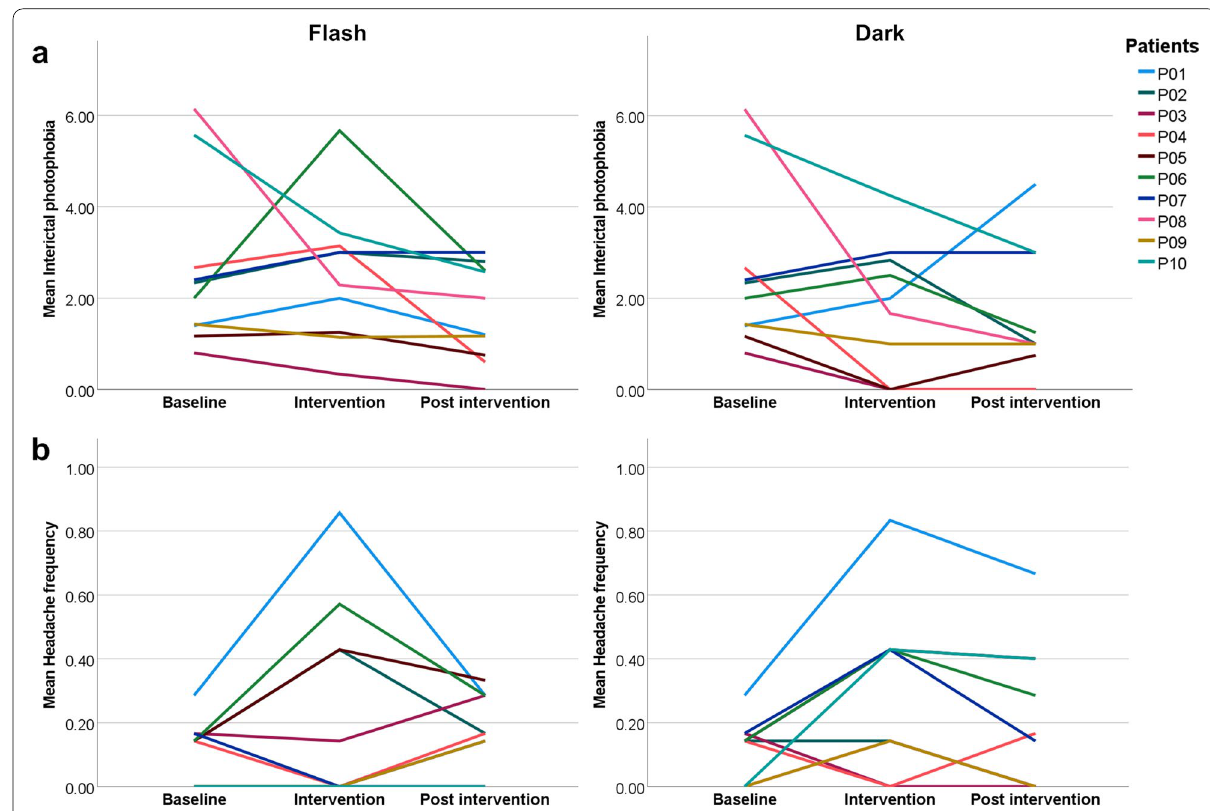
Fig. 2 Mean interictal photophobia ( a ) and mean headache frequency ( b ) at baseline, during the intervention (Flash or Dark) and post intervention, plotted for all patients (P01-P10) individually. Interictal photophobia scores dropped after the Flash and after the Dark intervention in most of the patients. Regarding headache frequency, individual responses to the interventions were heterogenous but returned to baseline levels after the